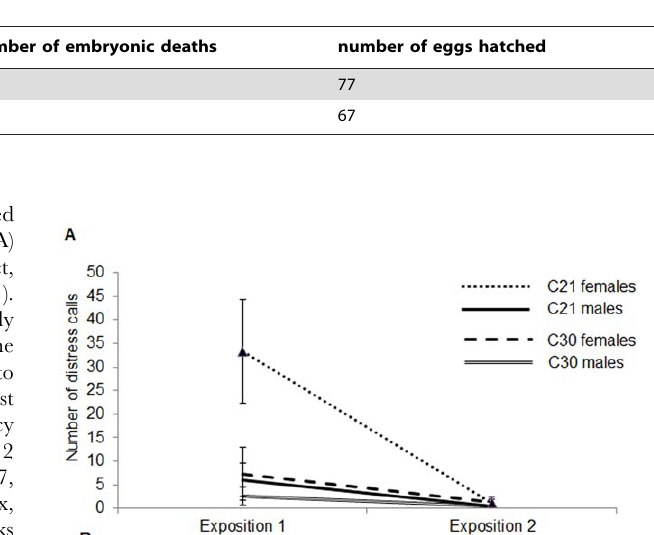
Table 2. Number of fertile eggs and hatching success in control and experimental hens.